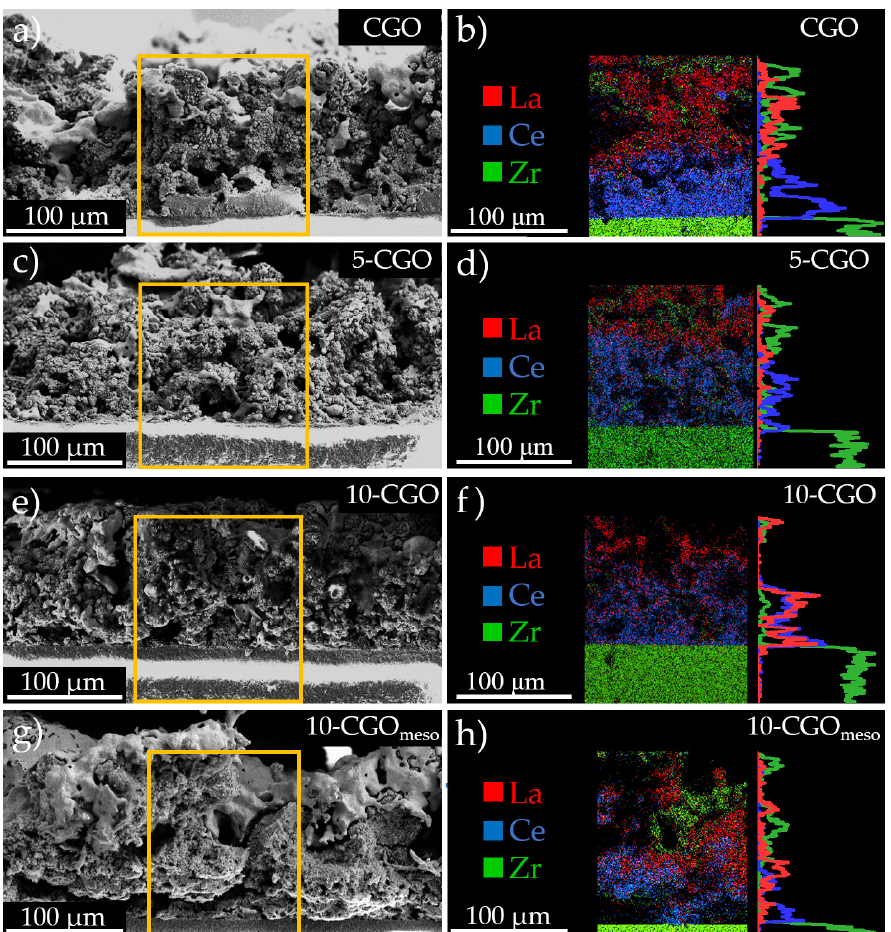
Figure 5. Representative SEM micrographs and EDX elemental maps of the CGO cell (panels ( a , b )), the 5-CGO cell (panels ( c , d )), the 10-CGO cell (panels ( e , f )) and the 10-CGO meso cell (panels ( g , h ). In all the EDX maps, the YSZ, CGO and LSCF phases are indicated by their main representative element. Zr (green), Ce (blue) and La (red) show the presence of YSZ, CGO and LSCF, respectively.